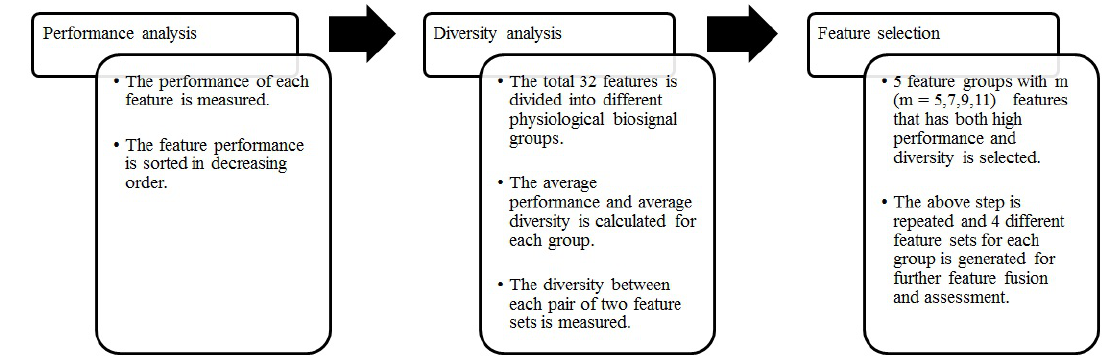
Figure 8. Feature selection approach (FSA).